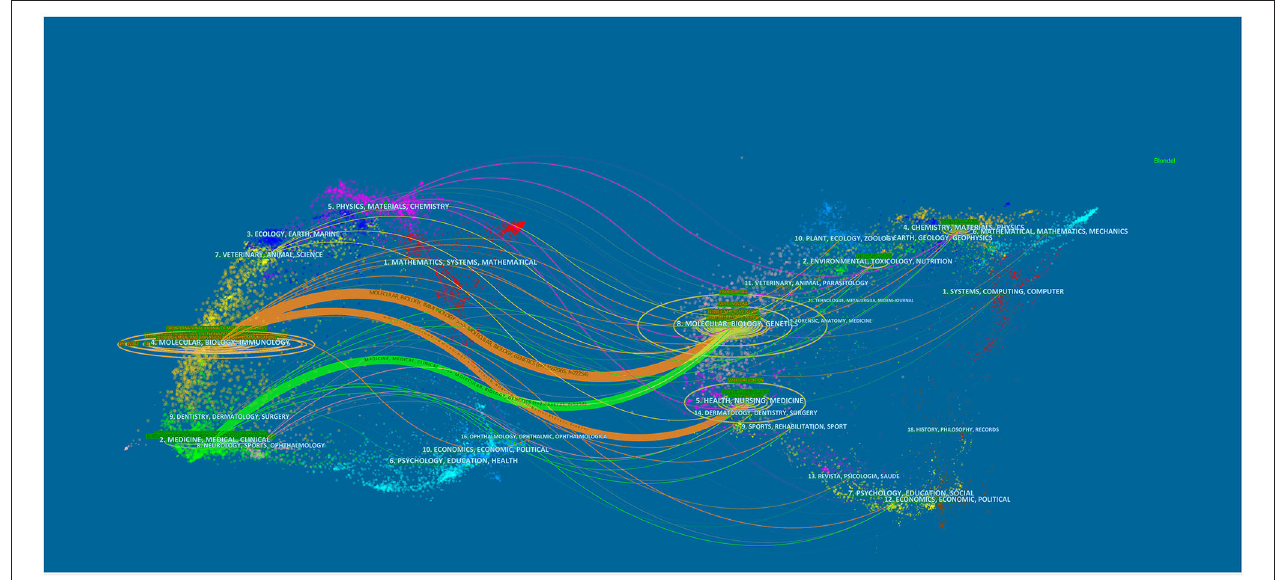
FIGURE 5 | The dual-map overlay of journals on exosomes in CVDs.